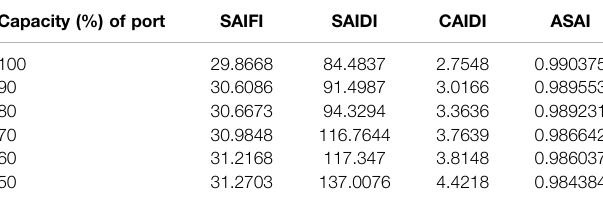
TABLE 2 | The original reliability parameters of the power system components.